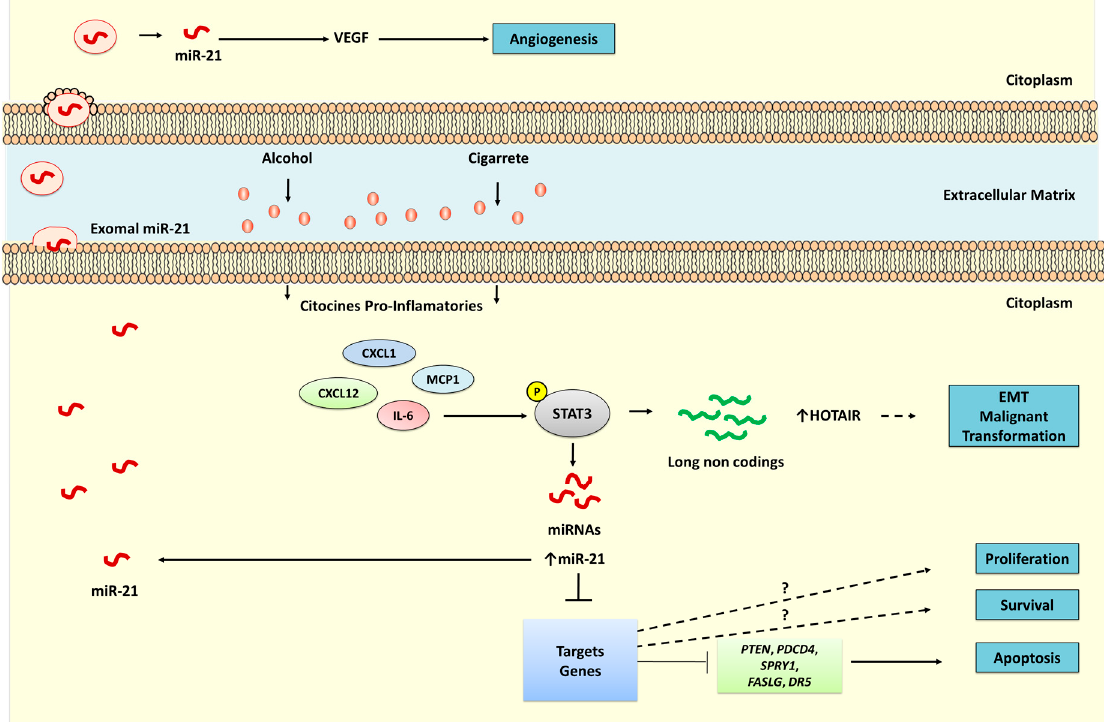
Figure 2. Induction of cellular inflammatory processes by tobacco and alcohol. Tobacco and alcohol induce inflammatory processes primarily through the interleukin 6 (IL-6)/signal transducer and activator of transcription 3 (STAT3) pathway. Phosphorylation of STAT3 by IL-6 governs the expression of miRNAs and long noncoding RNAs (lncRNAs). In aortic artery aneurysms and lung and liver cancers, miR-21 is associated with alterations in the IL-6/STAT3 pathway. Cells chronically exposed to cigarette smoke extract (CSE) show increased expression and secretion of miR-21 in exosomes and greater angiogenesis. CSE also induces the epithelial–mesenchymal transition (EMT) and upregulates the HOX transcript antisense RNA (HOTAIR) lncRNA. This pathway is involved in many processes, thus representing a new approach for identifying therapeutic targets in disorders associated with the use of alcohol and tobacco. miR-21: microRNA-21; VEGF: Vascular endothelial growth factor; MCP1: monocyte chemotactic protein-1; CXCL12: stromal cell–derived factor-; CXCL1: chemokine C-X-C motif ligand 1; IL-6: interleukin-6; STAT3: Signal transducer and activator of transcription 3; PTEN : phosphatase and tensin homolog; PDCD4 : programmed cell death 4; SPRY1 : sprouty-1; FASLG :